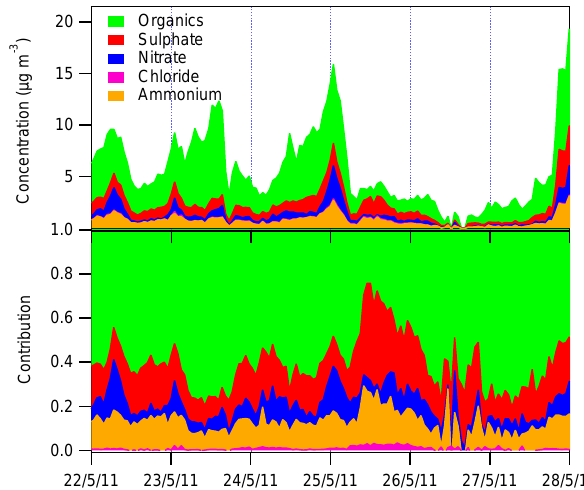
Fig. 7. Mass concentrations (top panel) and relative abundances (bottom panel) of particulate organic matter, sulfate, nitrate, am- monium and sodium measured by the ACSM in the PM 1 aerosol particles between 22 and 28 May